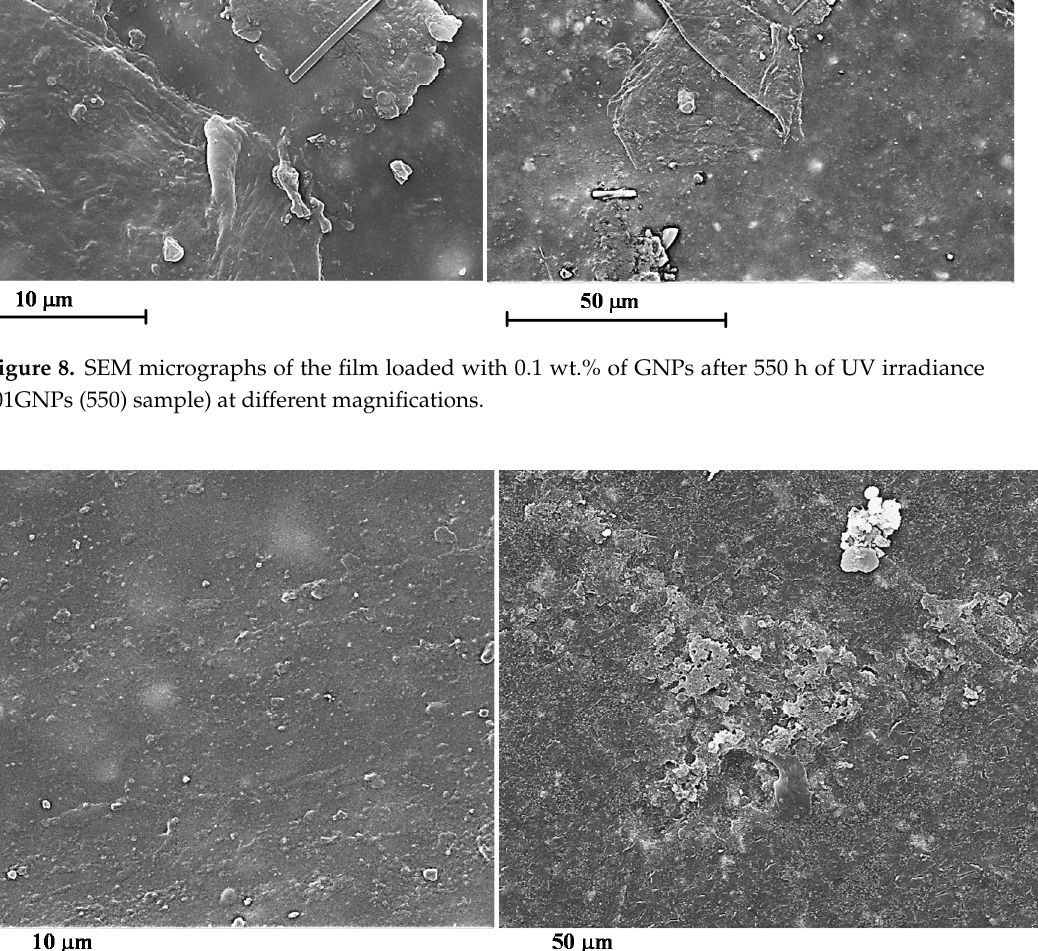
Figure 9. SEM micrographs of the films 1GNPs (on the left side) and 1GNPs (550) (on the right side) at different magnifications.